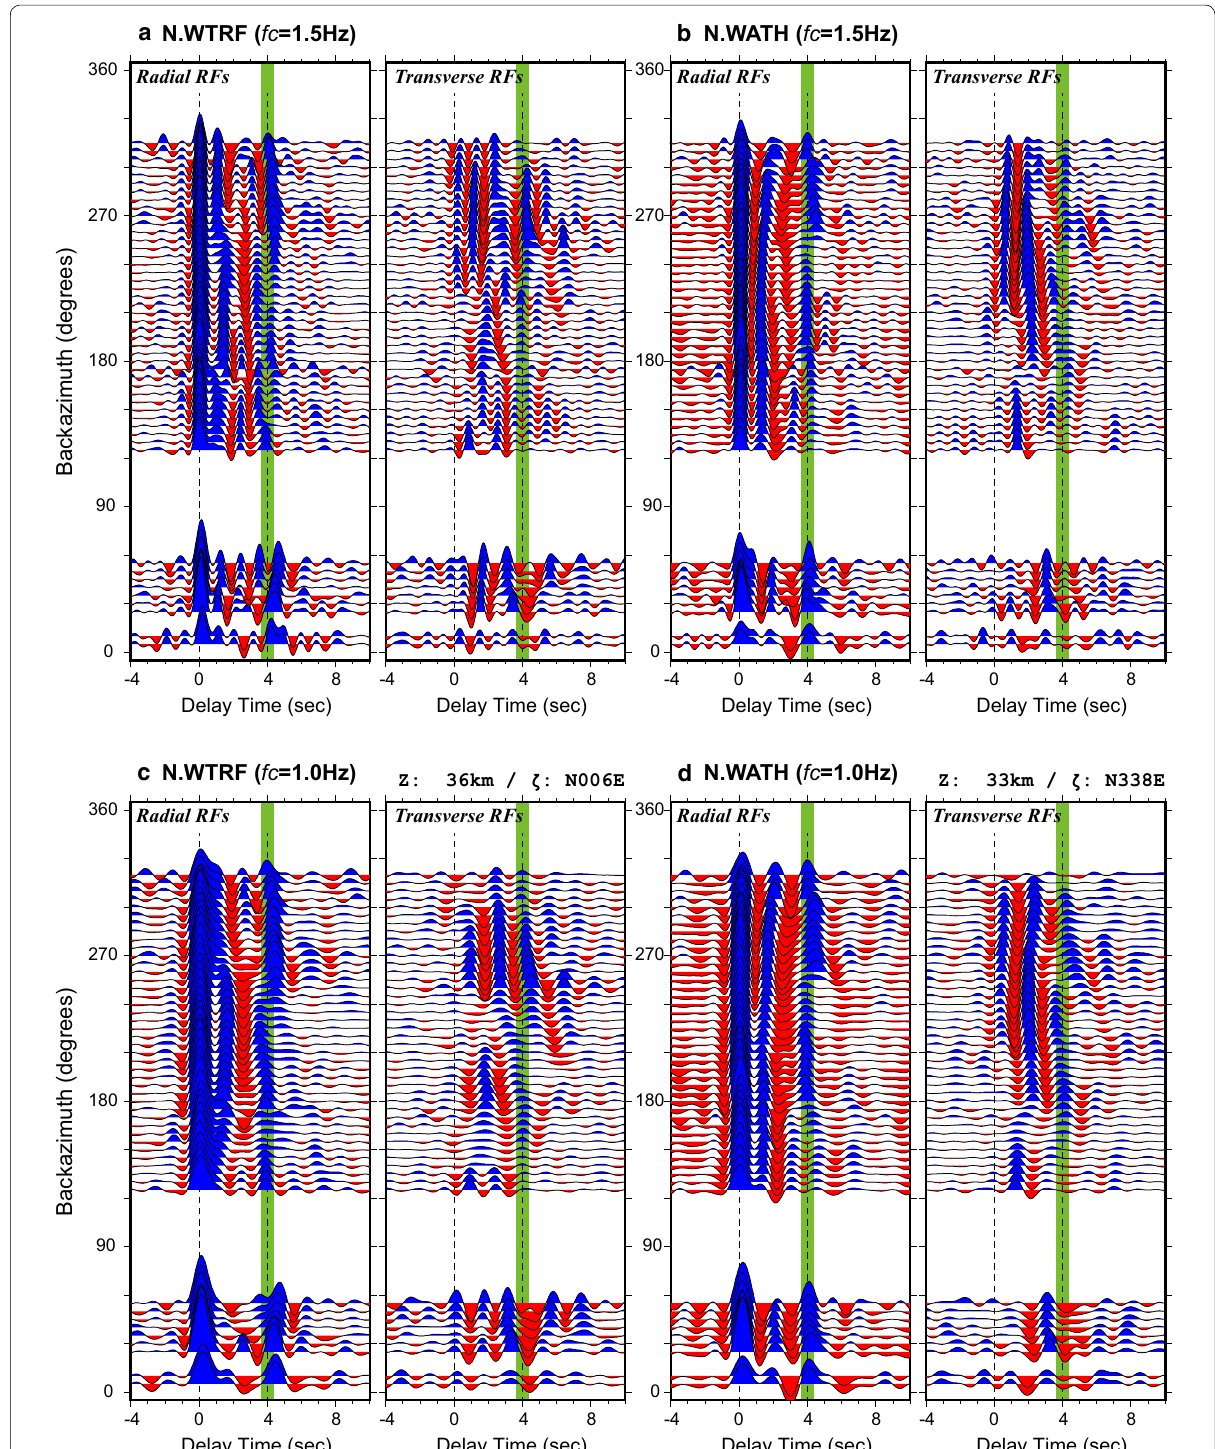
Fig. 2 Estimated receiver functions. Receiver functions observed at N.WTRF ( a , c ) and N.WATH ( b , d ). Low-pass filters with f c 1.0 Hz ( c , d ) were applied. Horizontal and vertical axes represent delay time and backazimuth of teleseismic waveforms, respectively. Vertical green lines indicate the assumed arrival time of converted phases at the oceanic Moho discontinuity. The depth of Moho discontinuity ( z ) and plunge azimuth ( ζ ) reported by Shiomi and Park (2008) are shown on the right top of c and